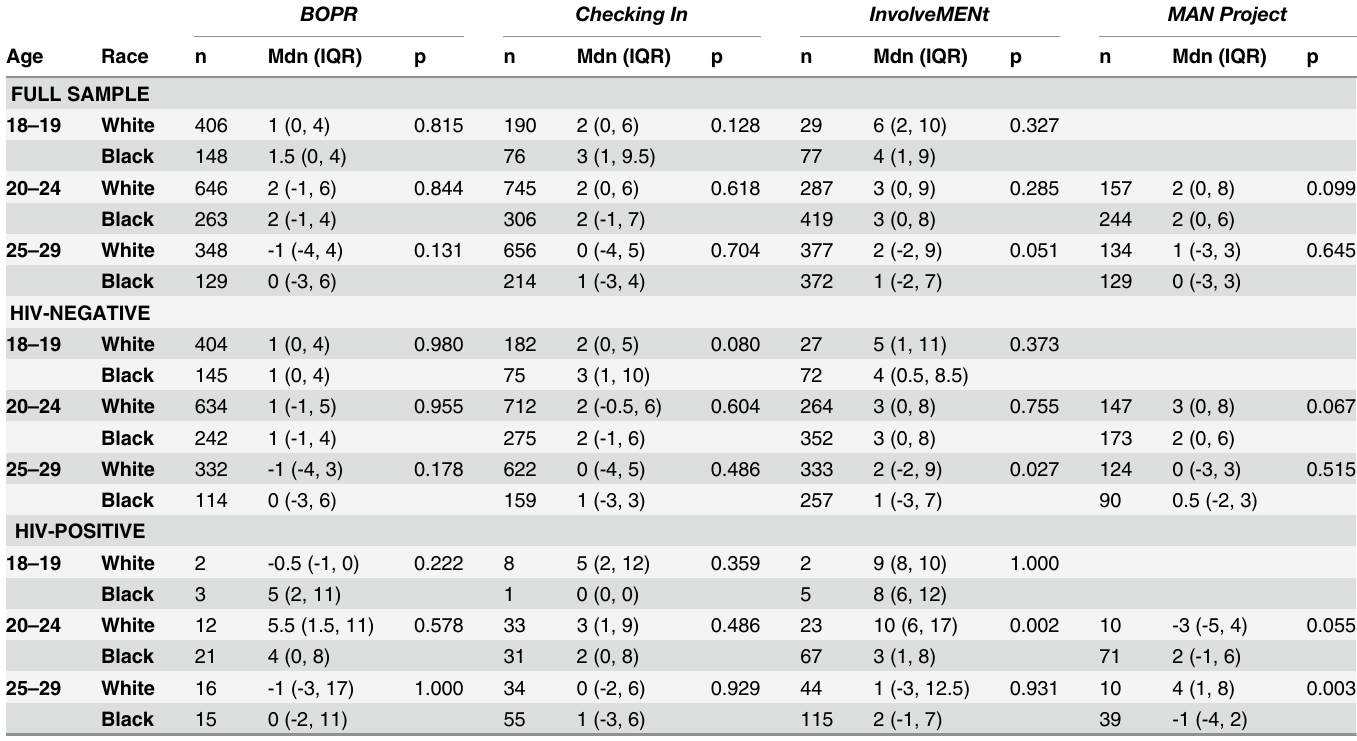
Table 2. Median partner age difference by self-reported HIV status, race, and age group (N = 6,352). BOPR Checking In InvolveMENt MAN Project